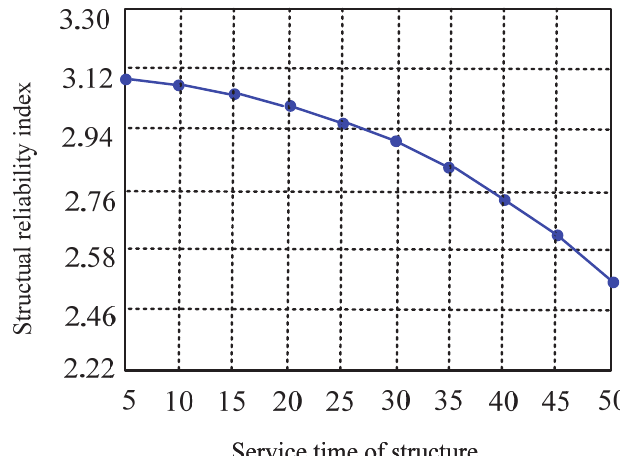
Figure 4. The changes of reliability index of corroded bending element of reinforced concrete along with service time of structure.